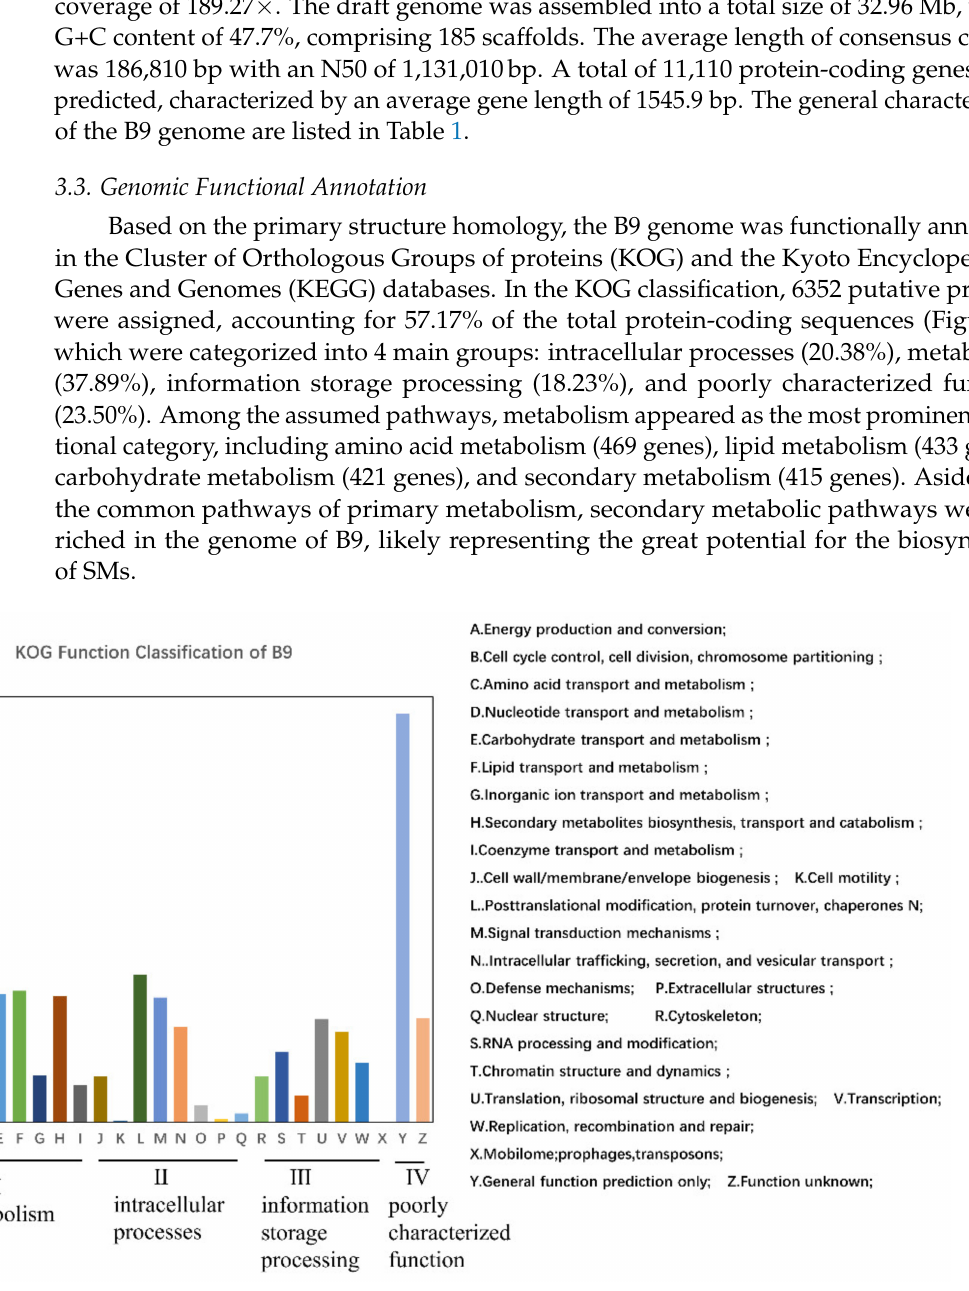
Figure 2. KOG classifications of putative proteins in the genome of B9. I: metabolism; II: intracellular processes; III: information storage/processing; IV: poorly characterized